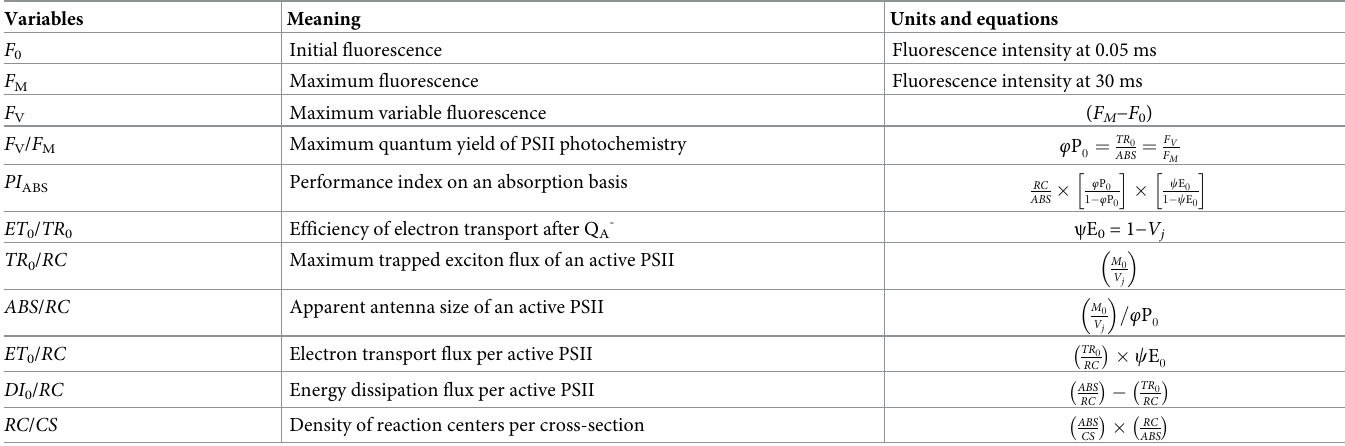
Table 1. ChF variable meanings, units and equations